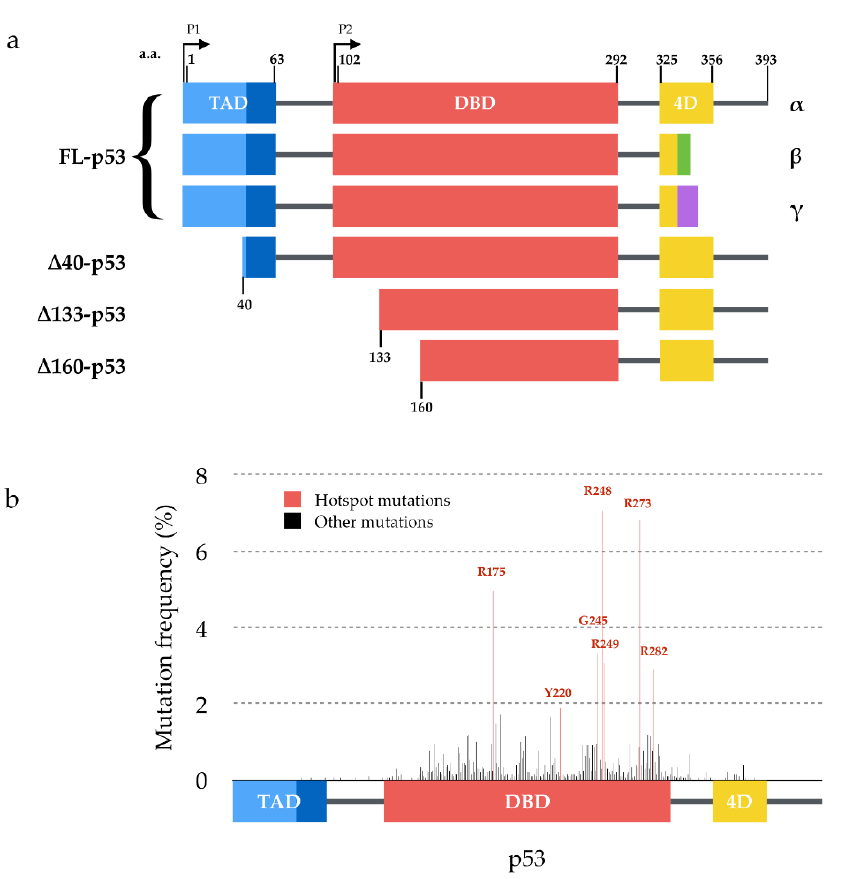
Figure 1. Structure of p53 isoforms and distribution of mutations within p53. ( a ) p53 isoforms are generated from the use of two alternative promoters (P1 and P2), secondary initiation codons (∆40, ∆133 or ∆160) and/or alternate splicing sites (α, β or γ C-termini) leading to 12 combinations described to date. ( b ) Distribution and frequency of p53 mutations described in human tumors (data from the International Agency for Research on Cancer). Hotspot mutations are shown in red and are all located within the DNA binding domain of p53.